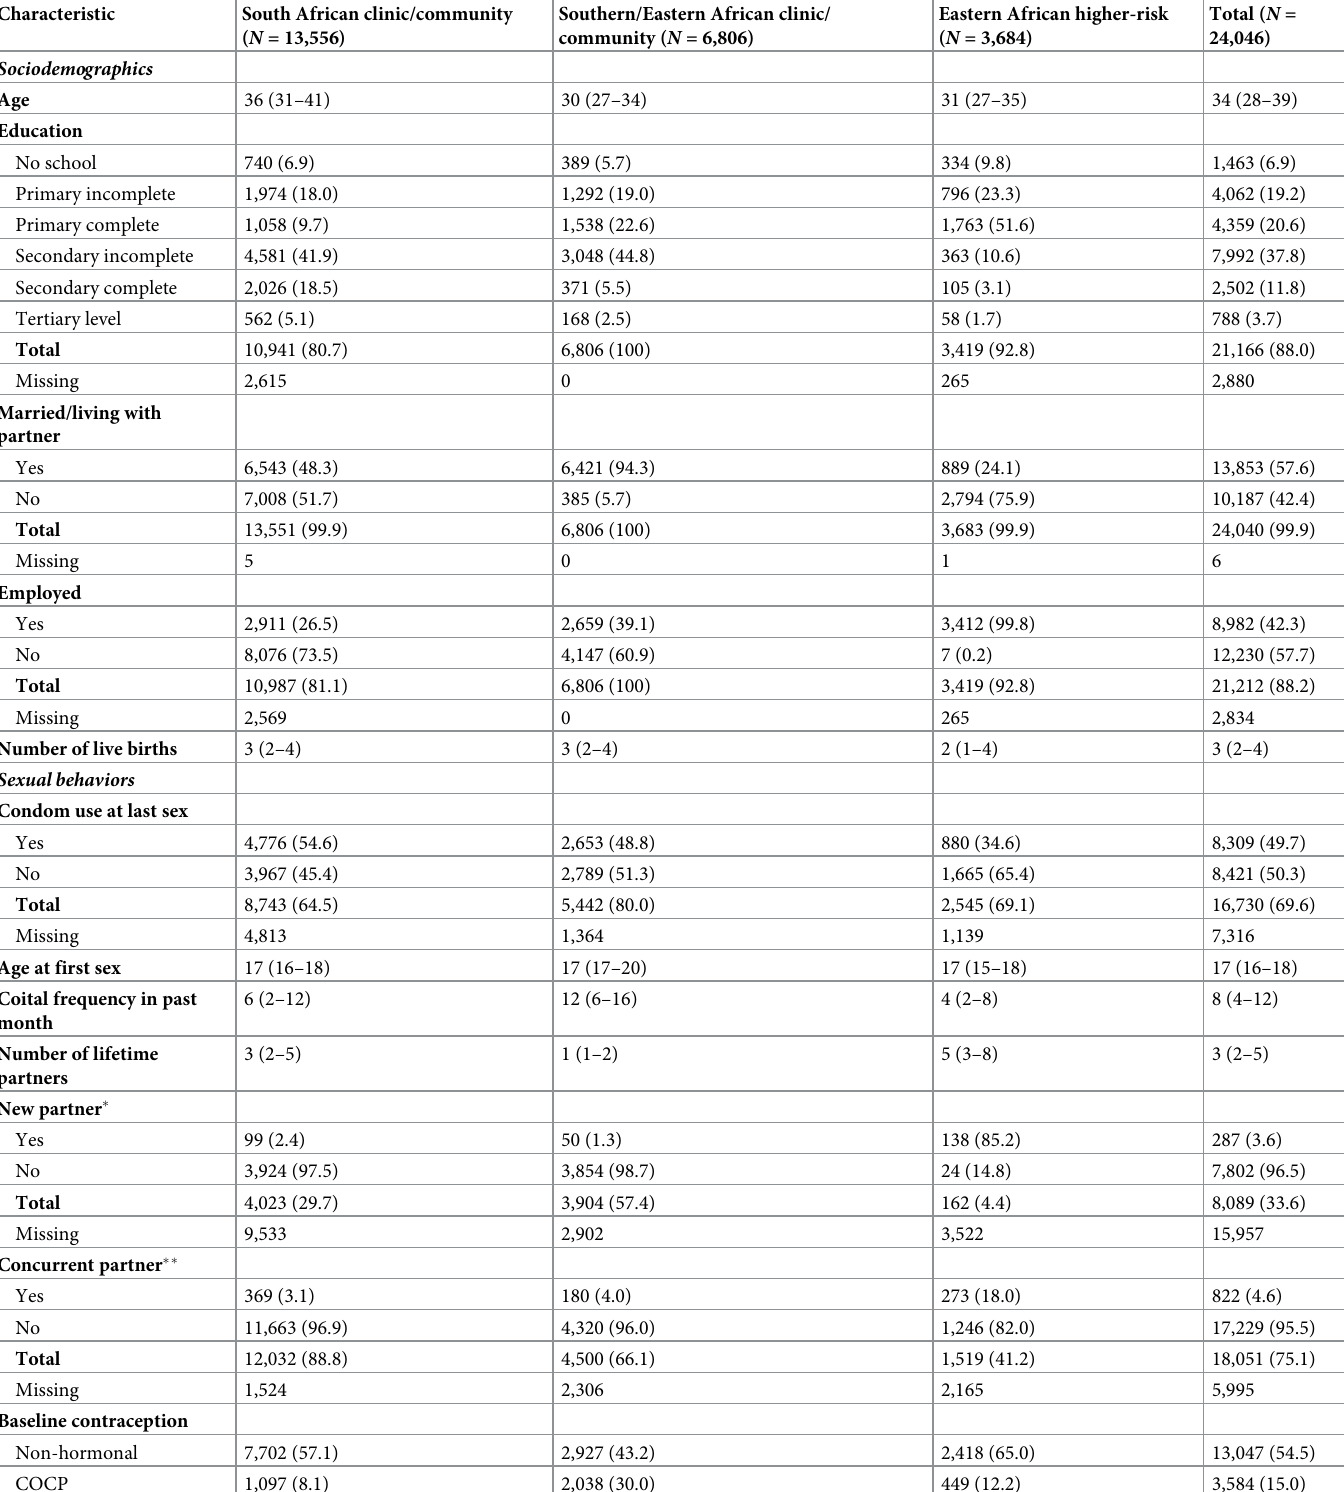
Table 3. Baseline characteristics by region/population type among participants aged 25–49